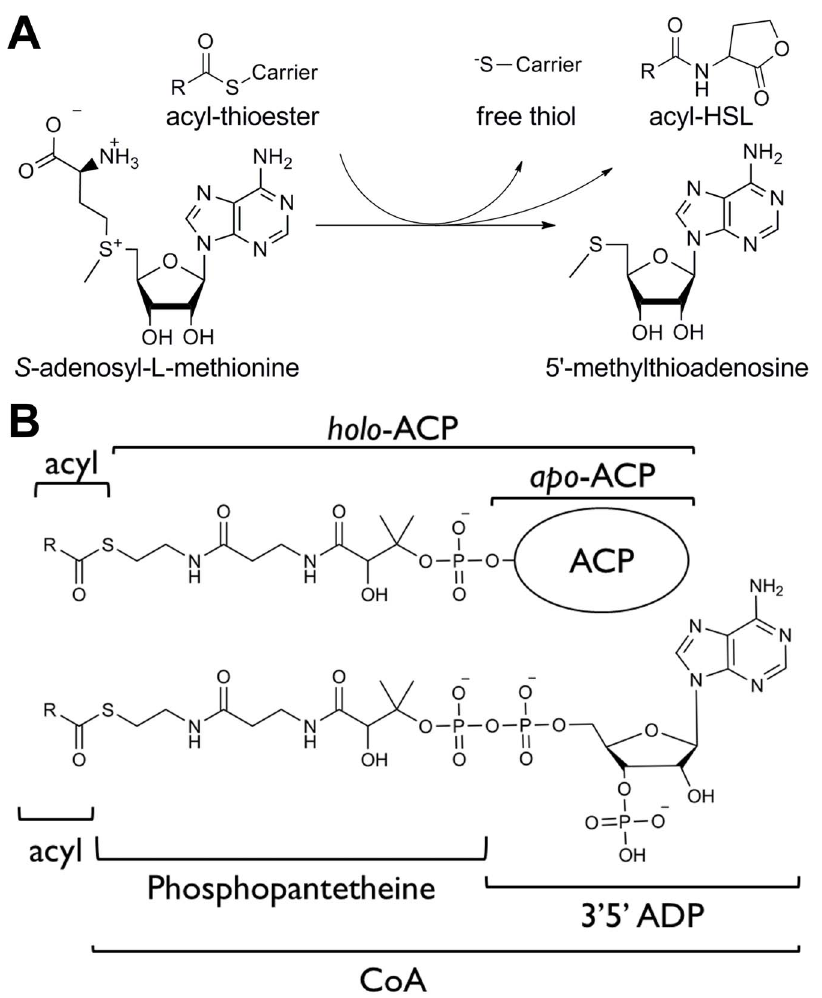
Figure 1. Substrates and products of acyl-HSL synthases. A) Acyl-HSL synthases have two substrates and three products. The substrate acyl group is attached as a thioester to an acyl carrier: either an acyl carrier protein or coenzyme A . B) Comparison of the structures of acyl-ACP and acyl- CoA. Both carriers have an acyl-phosphopantetheine (acyl-PPant) moiety. Thioether analogs of these thioester substrates lack the acyl oxygen.